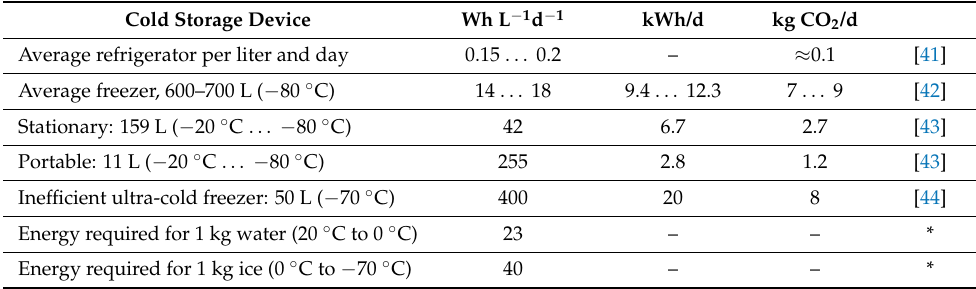
Table 2. Typical carbon footprint of freezers in CO 2 equivalents.